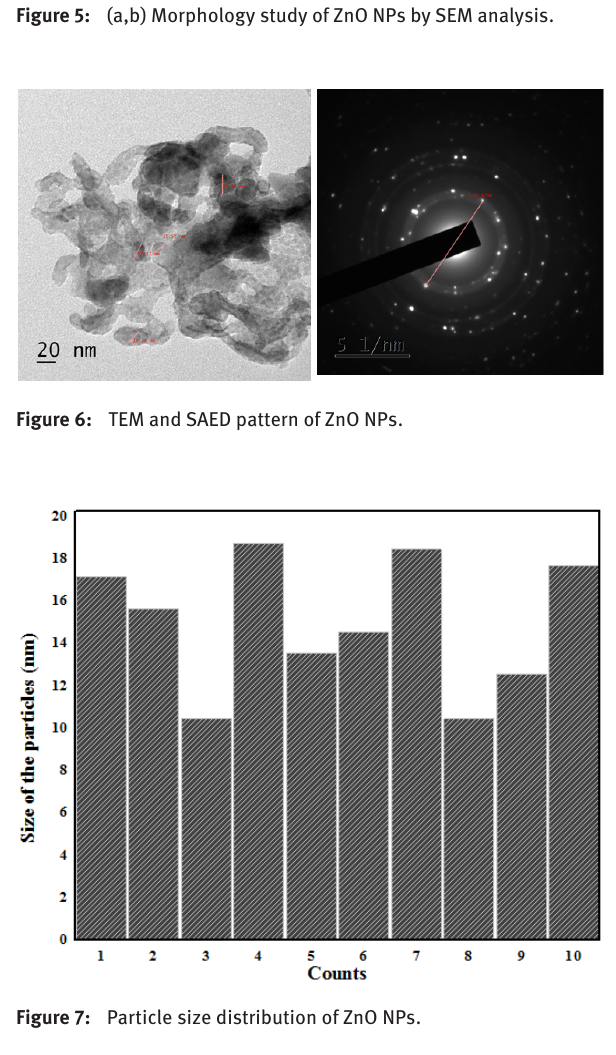
Figure 5: (a,b) Morphology study of ZnO NPs by SEM analysis.